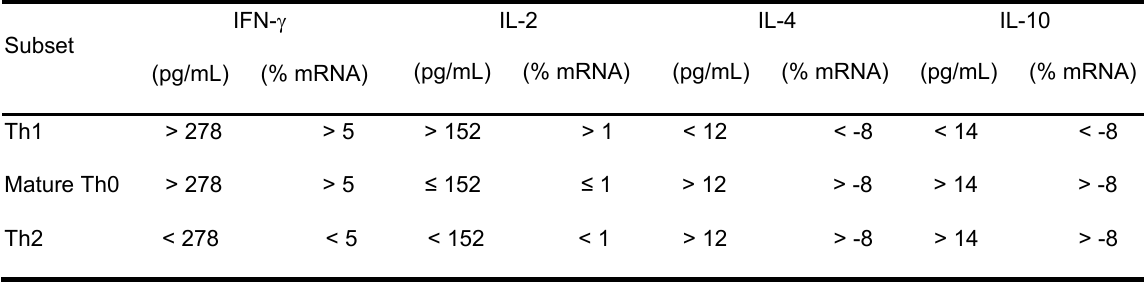
Table 4. Serum and mononuclear cell cytokine subsets according to normal values, obtained